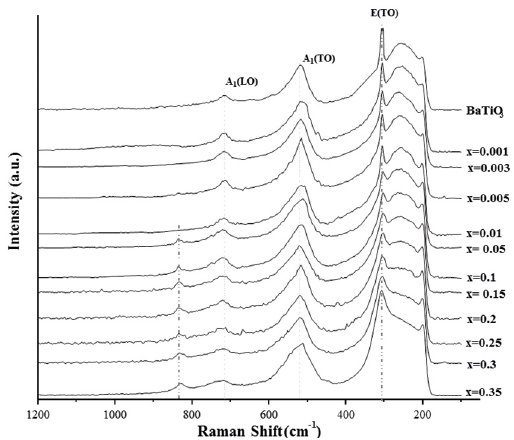
Figure 3: Raman spectra of powders sintered at 1400 °C, 0 ≤ x ≤ 0.3.